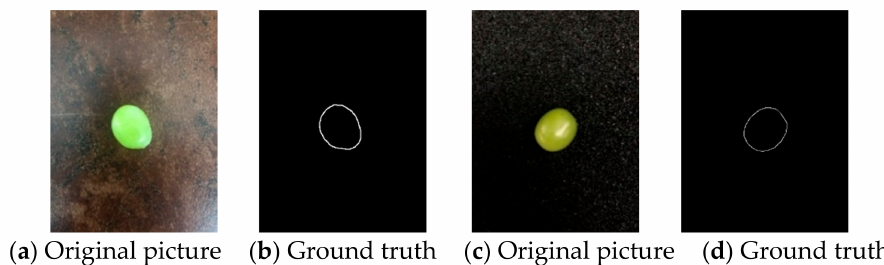
Figure 7. Original images and artificially labeled contour maps as ground truth.